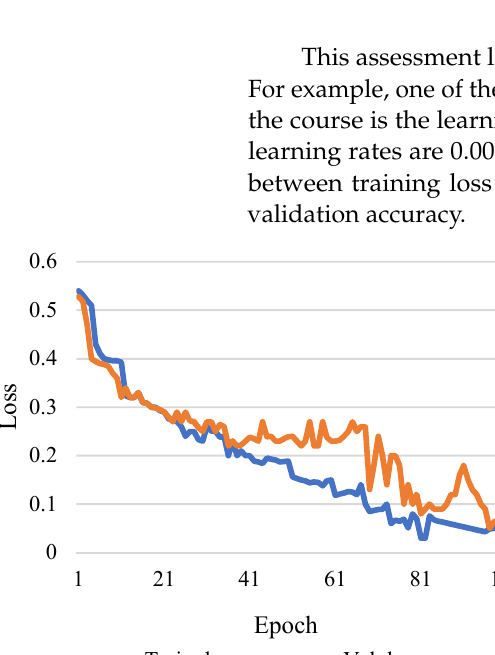
Figure 5. ( a ) Training loss vs validation loss (rate of learning 0.0001 and epoch 100). ( b ) Training accuracy vs validation accuracy (rate of learning 0.0001 and epoch 100).